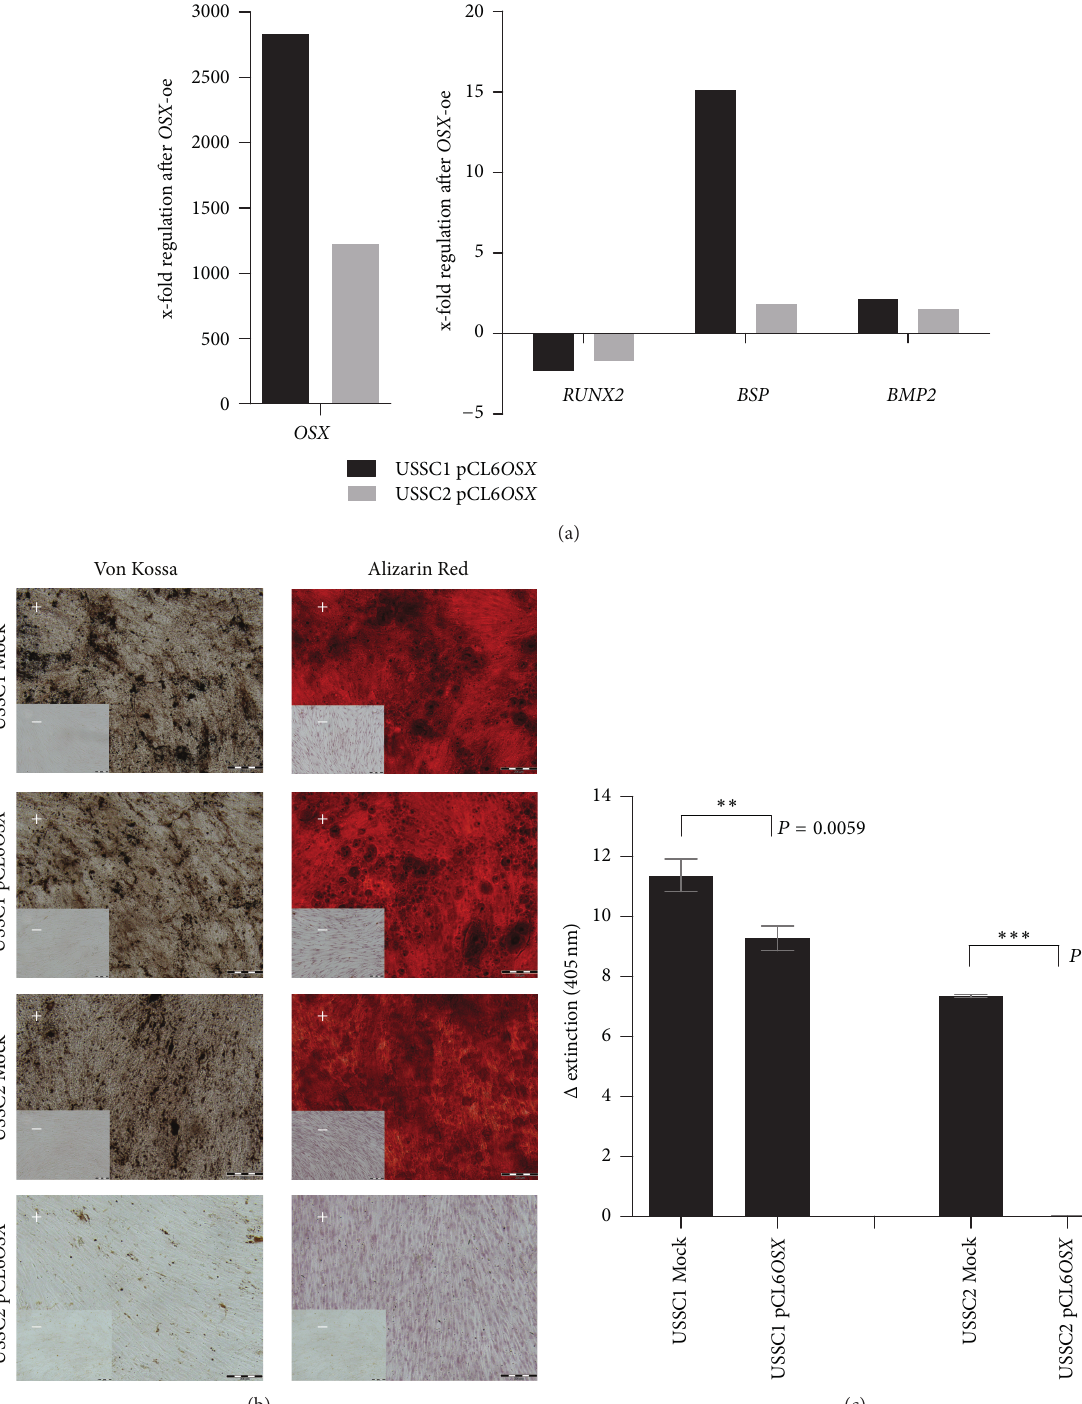
Figure 4: Lentiviral overexpression of OSX in two USSC cell lines. (a) Quantitative RT-PCR analysis of gene expression (in undifferentiated cells) after overexpression in relation to the control cells (Mock). RPL13A was used as housekeeping gene. (b) Osteogenic differentiation experiments in overexpressed and Mock cells. After 14 days of differentiation, Von Kossa and Alizarin Red S staining were performed in the induced (+) and non-induced ( − ) cells. Mineralized areas are stained in brown/black or red, respectively. Scale bar: 200 𝜇 m. The results were confirmed in independent experiments; representative histological staining and the subsequent quantification of the bound Alizarin Red S- dye (c) are depicted. ∗∗ 𝑃 = 0.001 to 0.005, very significant; ∗∗∗ 𝑃 < 0,001 , extremely significant (unpaired 𝑡 -test). OSX (SP7) : osterix, RUNX2 : runt-related transcription factor 2, BSP : integrin-binding sialoprotein, BMP2 : bone morphogenetic protein 2, and RPL13A : ribosomal protein